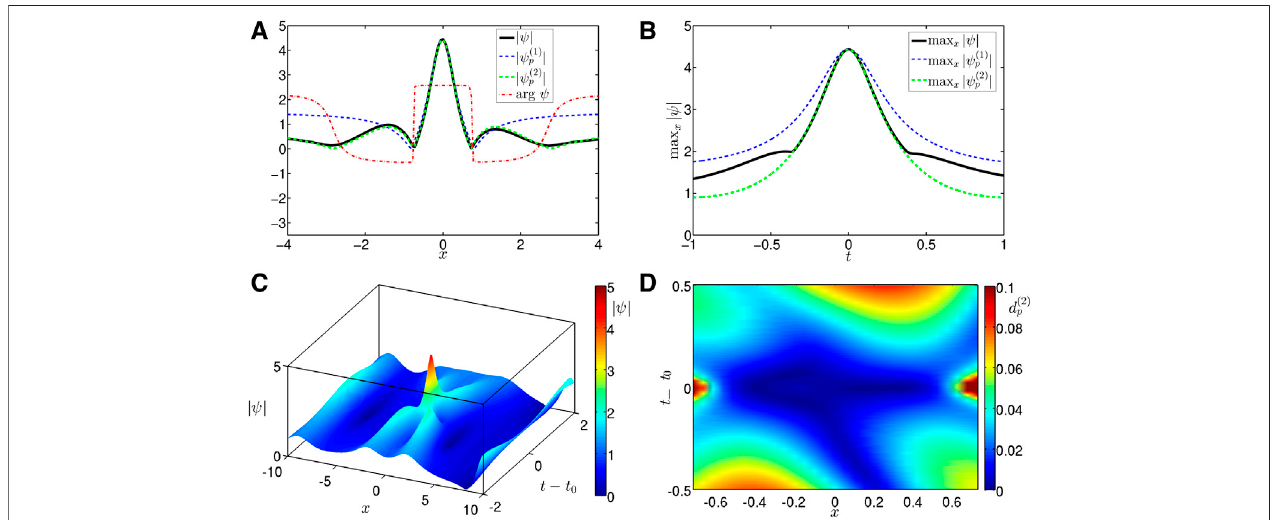
FIGURE 1 | ( Color on-line ) One of the 10 largest RWs (the coordinate of maximum amplitude is shifted to zero for better visualization) for the soliton gas case with time of occurrence t 0 ≈ 39 . 2, maximum amplitude A ≈ 4 . 4 and deviation Eq. 7 from the RBS2 D ( 2 ) p ≈ 0 . 02: (A) space pro fi le of the RW maximum elevation, (B) time dependency of the maximum amplitude max x relativedeviation Eq.6 betweenthewave fi eldandthe fi twiththeRBS2inthe ( x , t ) -plane.Inthepanel (A) ,thethickblackandthethindash-dotredlinesindicatethe (cid:1)(cid:1)(cid:1)(cid:1) (cid:1)(cid:1)(cid:1)(cid:1) ) ψ ( x , t and the phase arg ψ ( x , t 0 ) . In the panels (A,B) , the dashed blue and green lines show the fi ts with the RBS1 and the RBS2, respectively. In the space pro fi le 0 panel (D) , the deviations d ( 2 ) p ≥ 0 . 1 are demonstrated with constant deep red color.